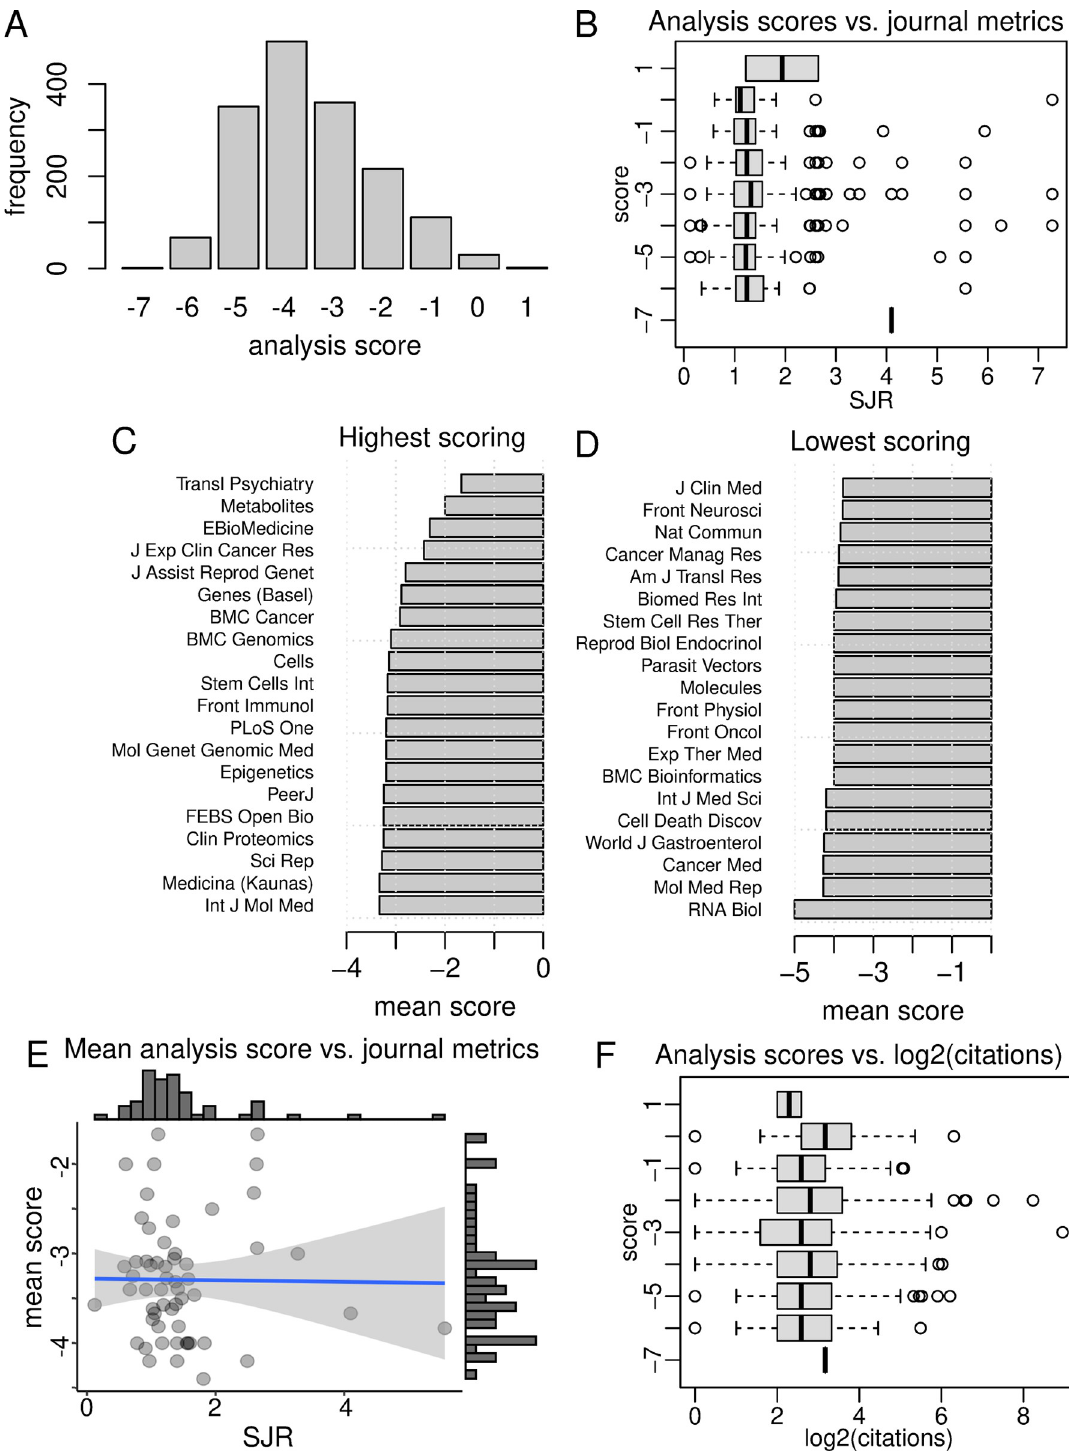
Fig 3. Comparison of analysis scores to bibliometrics. (A) Distribution of analysis scores. (B) Association of analysis scores with Scimago Journal Rank (SJR). (C) Journals with highest mean analysis scores. (D) Journals with lowest mean analysis scores. (E) Association of mean analysis score with SJR for journals with 5 or more analyses. (F) Association of analysis scores with accrued citations.